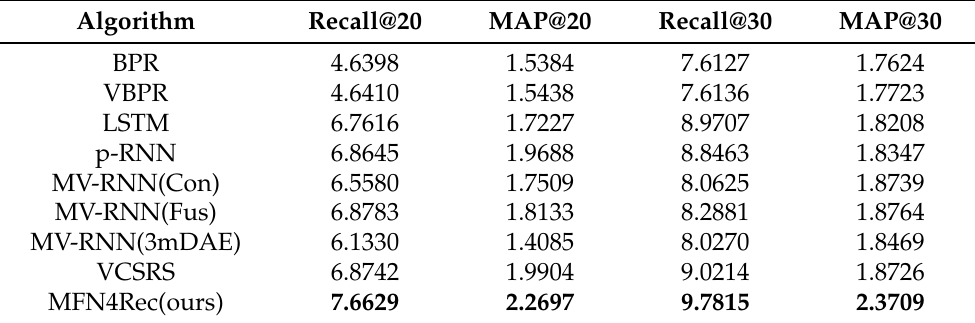
Table 4. The performance comparison with baseline algorithms on the Amazon Phone